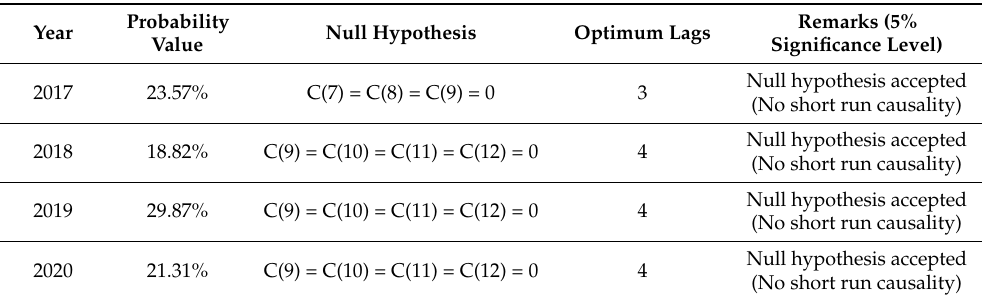
Table 7. Wald test for short run causality between experience and share performance (2017 to 2020).